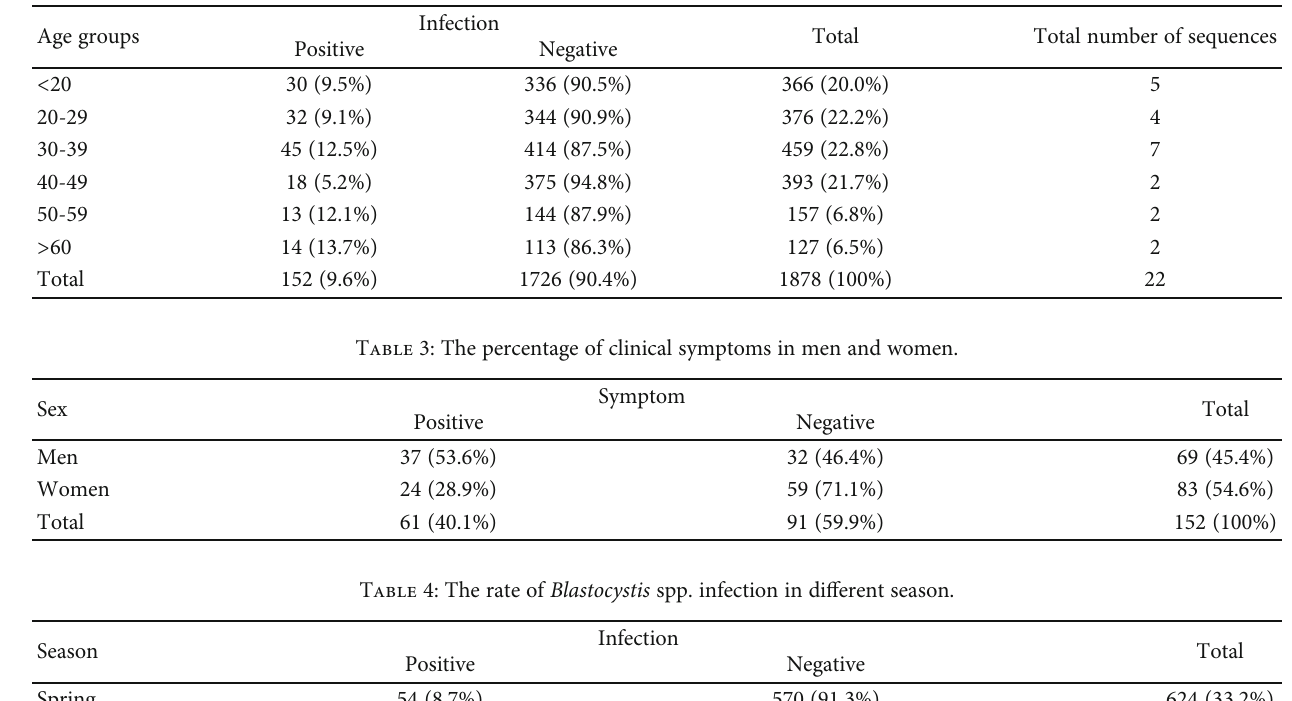
Table 2: The rate of Blastocystis spp. infection in di ff erent age groups and the number of sequenced cases in each group.